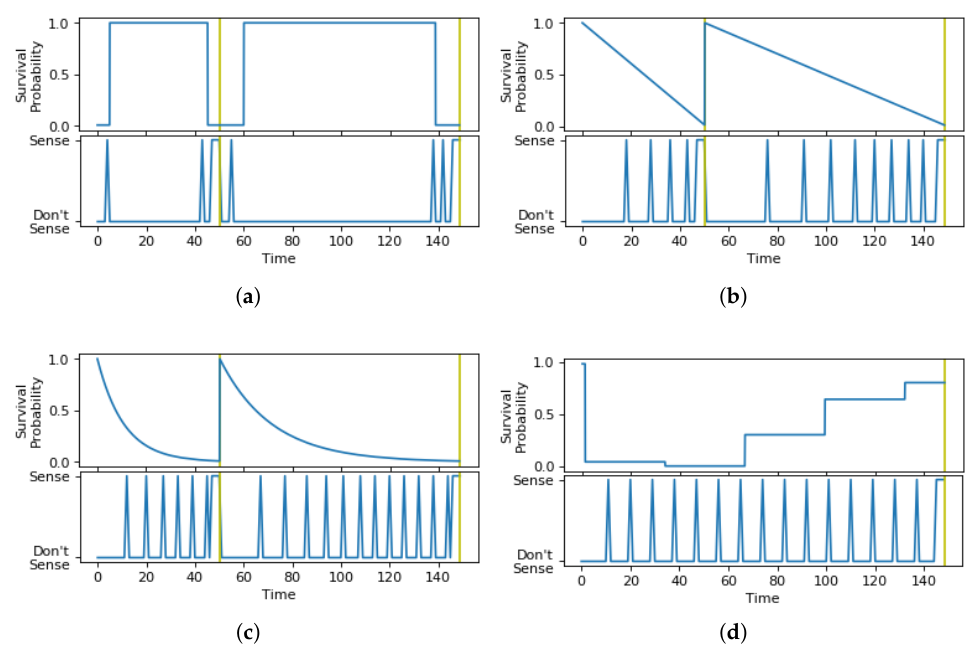
Figure 16. Illustration of impacts on the sensing schedule generated by the Viterbi algorithm using the ( a ) uniform function, ( b ) linear function, ( c ) exponential function, ( d ) distribution function.